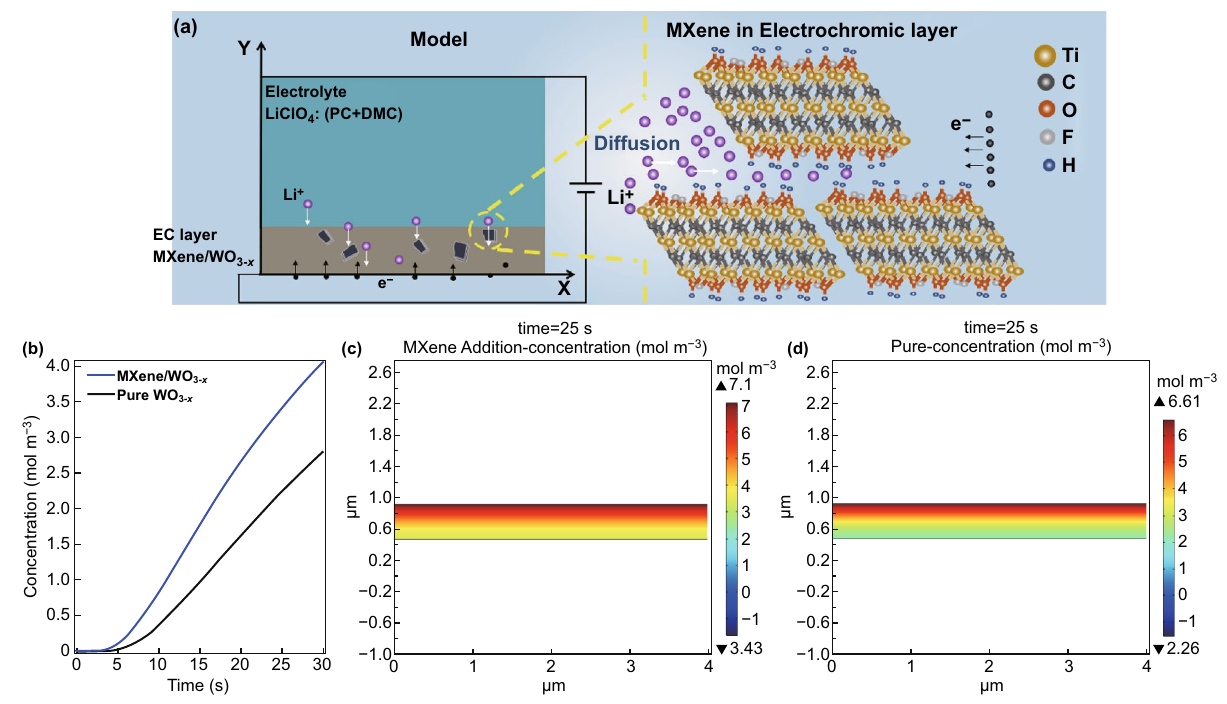
Fig. 6 a Model of the simulation and specific kinetic process of the lithium ion diffusion. b Time distribution of Li + in pure WO 3− x film and MXene/WO 3− x film. Spatial distribution (time = 25 s) of Li + in c MXene/WO 3− x film and d pure WO 3− x